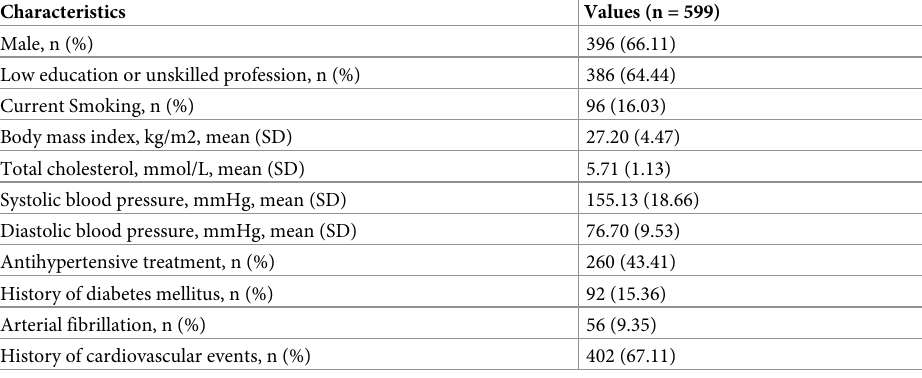
Table 3. Characteristics of study population of Leiden 85-plus